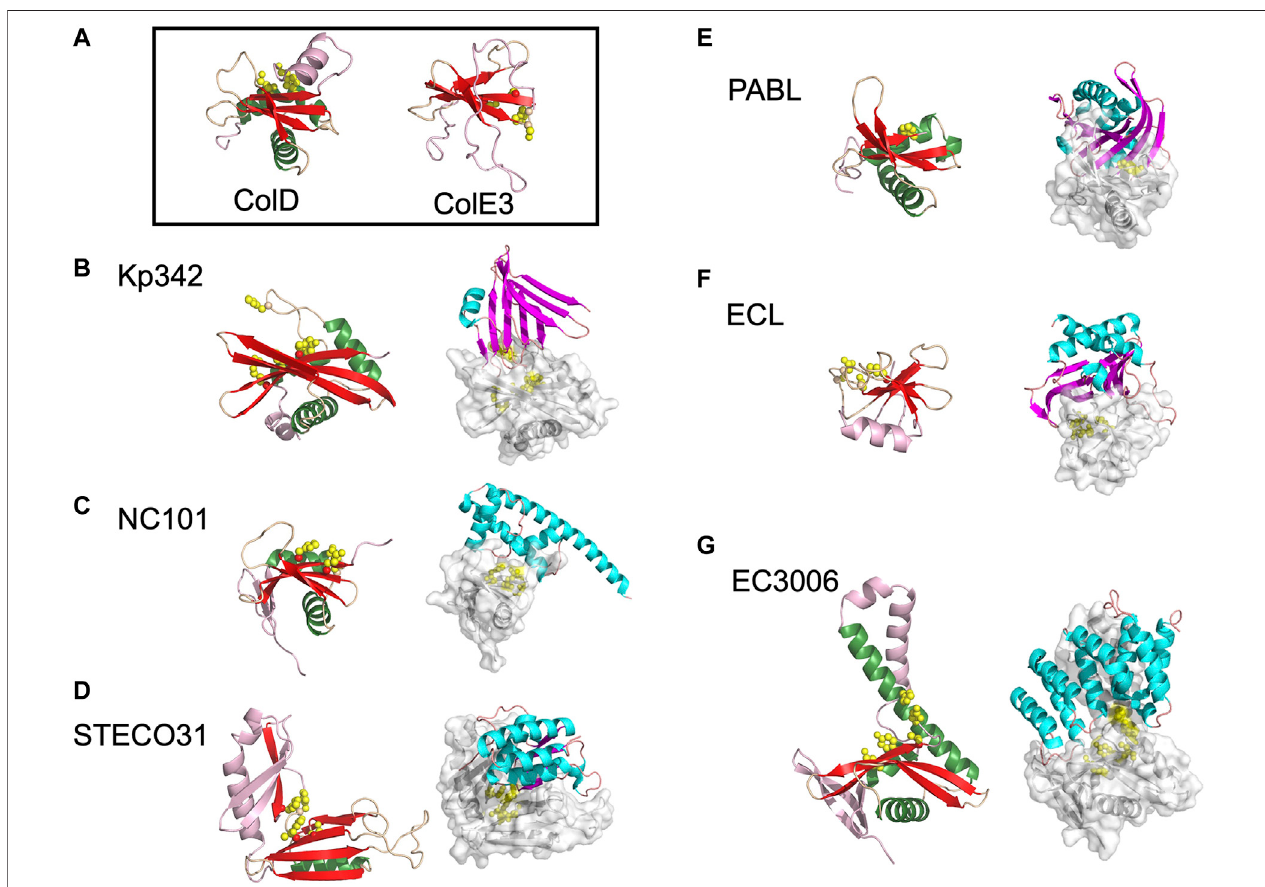
FIGURE2| Thediverse range ofstructuresfor BECRfamily CdiA-CTtoxinsand theirCdiA-CT/CdiI complexes. (A) AsrepresentativesofBECR structural foldswe show and box ColD (PDB ID: 5ZNM (Chang et al., 2018)) and ColE3 (PDB ID: 2B5U). ColD and ColE3 are colored as in the left panels described below. CDI BECR toxin and toxin/immunitycomplex structures are shown from: (B) K.pneumoniae 342(Kp342) [PDB ID: 6CP9 (Gucinski et al., 2019)], (C) E. coli NC101 [PDB ID: 5I4Q (Jones et al., 2017)], (D) E. coli STEC_O31 [PDB ID: 5HKQ (Michalska et al., 2018)], (E) P. aeruginosa PABL017 [PDB ID: 6D7Y (Allen et al., 2020)], (F) E. cloacae ATCC 13047(ECL)[PDBID:4NTQ(Becketal.,2014)],and (G) E.coli 3006(CdiA-CT/CdiI EC3006 )[PDBID:6CP8(Gucinskietal.,2019)].Foreachpair,theleftpaneldisplaysthe toxin alone in cartoon representation with its BECR core structure colored by secondary structure with β -strands in red, α -helices in green, and loops in wheat, and the remainder of the secondary elements are colored in light pink. Active site residues are shown as yellow spheres. In the right panel is the CdiA-CT/CdiI complex with CdiI colored by secondary structure: β -strands in magenta, α -helices in cyan, and loops in salmon. CdiA-CT has a semi-transparent molecular surface with white cartoon representation and with active site residues shown as yellow